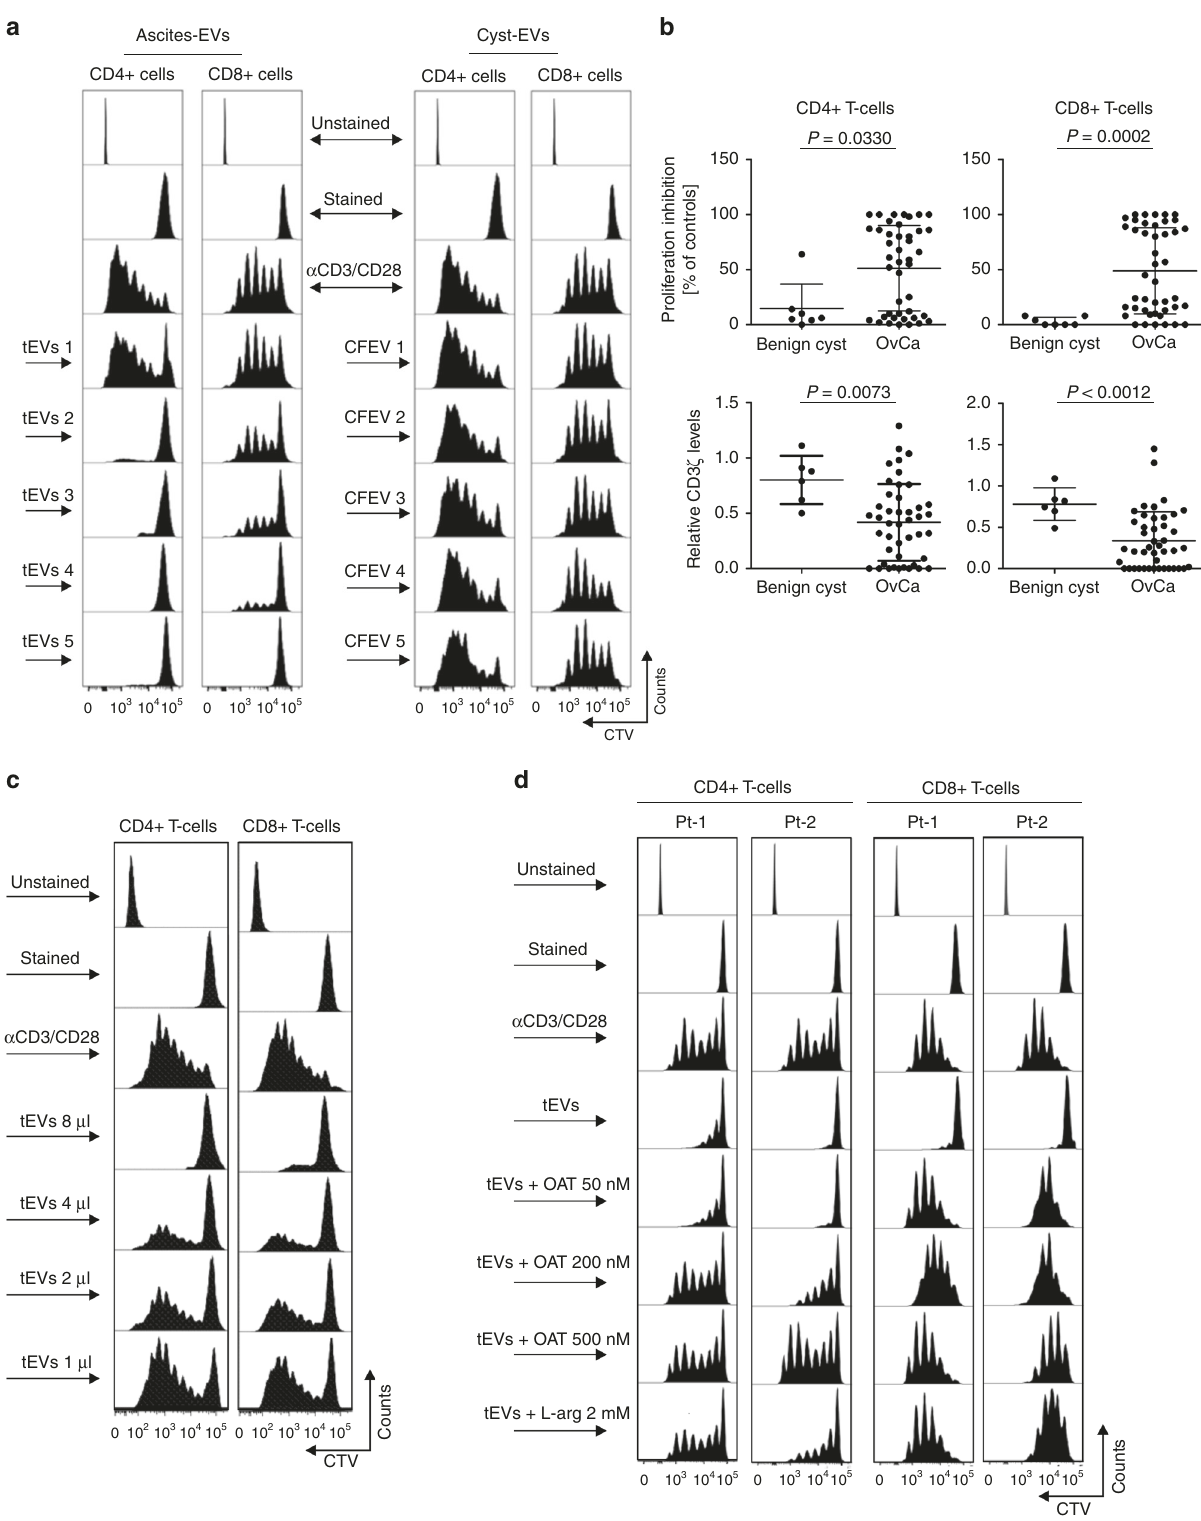
mice. Immunoblotting of lysates of local LNs demonstrated the presence of V5 tag at 4 and 24 h post tEVs inoculation (Fig. 6a), indicating that the injected tEVs were being transported to the draining LNs. Subcutaneously inoculated EVs-ARG1 signi fi cantly inhibited OVA-speci fi c proliferation of adoptively transferred OT-I T-cells ( P = 0.0275, Kruskal – Wallis with Dunn ’ s multiple comparison test), whereas inoculation of control EVs-pLVX had